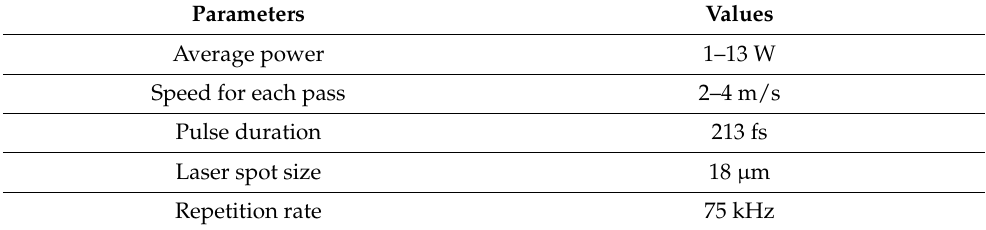
Table 2. Variable and fixed process parameters implemented in laser texturing of NiTi tape.